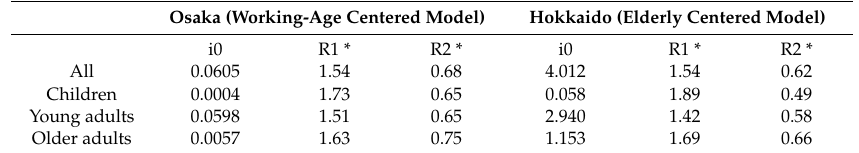
Table 1. Estimated parameters for describing the dynamics of the model for hospital admissions.